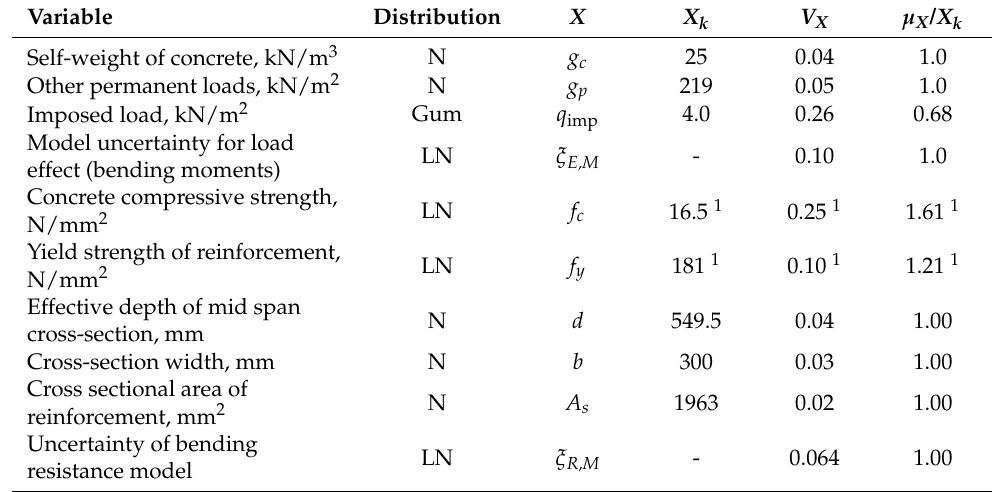
Table 3. First stage probabilistic models for basic variables adopted for the assessment according to [9].